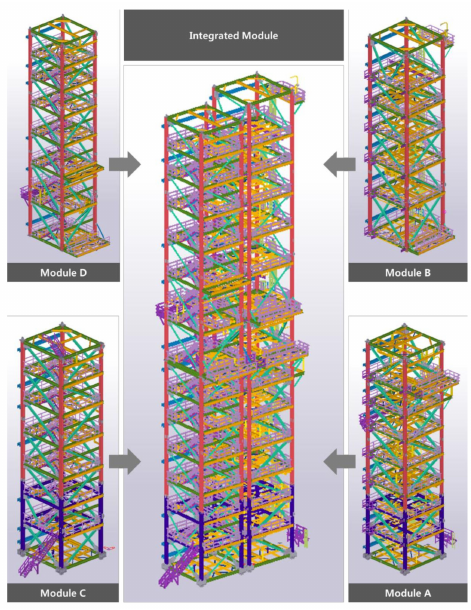
Figure 2. Module composition of case